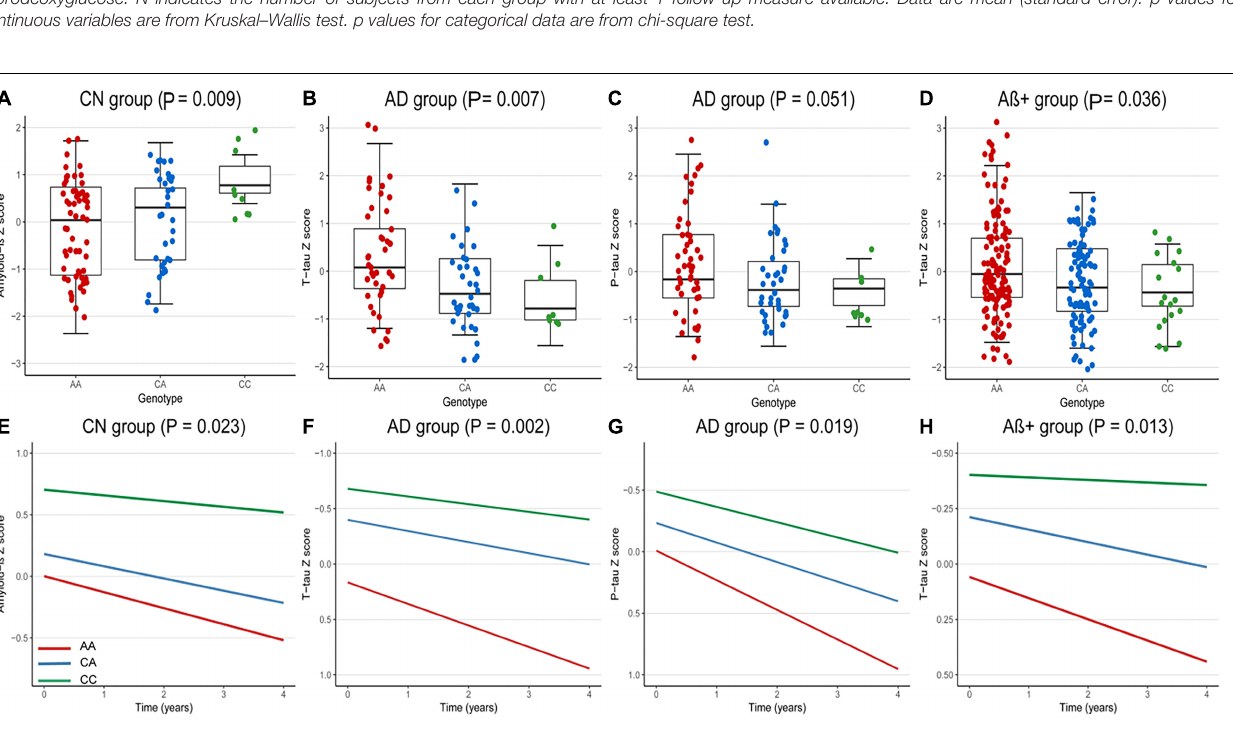
FIGURE 1 | The correlation between rs9357347 and CSF markers. (A–D) The relation between CSF protein and rs9357347 allele at baseline. (A) The statistical relation between CSF A β 1 - 42 and rs9357347 allele in CN group; (B) rs9357347 was associated with the level of T-tau in AD group; (C) rs9357347 was closely associated with P-tau in AD group; (D) rs9357347 was associated with the level of T-tau in A β -abnormal (CSF A β 1 - 42 ≤ 192 ng/L) group; (E–H) The relation between CSF protein and rs9357347 allele longitudinally (4 years’ follow-up). (E) The statistical relation between CSF A β 1 - 42 and rs9357347 allele in CN group; (F) rs9357347 was associated with the level of T-tau in AD group; (G) rs9357347 was associated with P-tau 181 in AD group; (H) rs9357347 was associated with the level of T-tau in A β -abnormal group; The model at baseline was multiple linear regression model adjusted for age, gender, educational level, and APOE ε 4 genotype. The model in longitudinal study was multiple mixed-effects model adjusted for age, gender, educational level, and APOE ε 4 genotype. A β +, A β -abnormal; A β –, A β